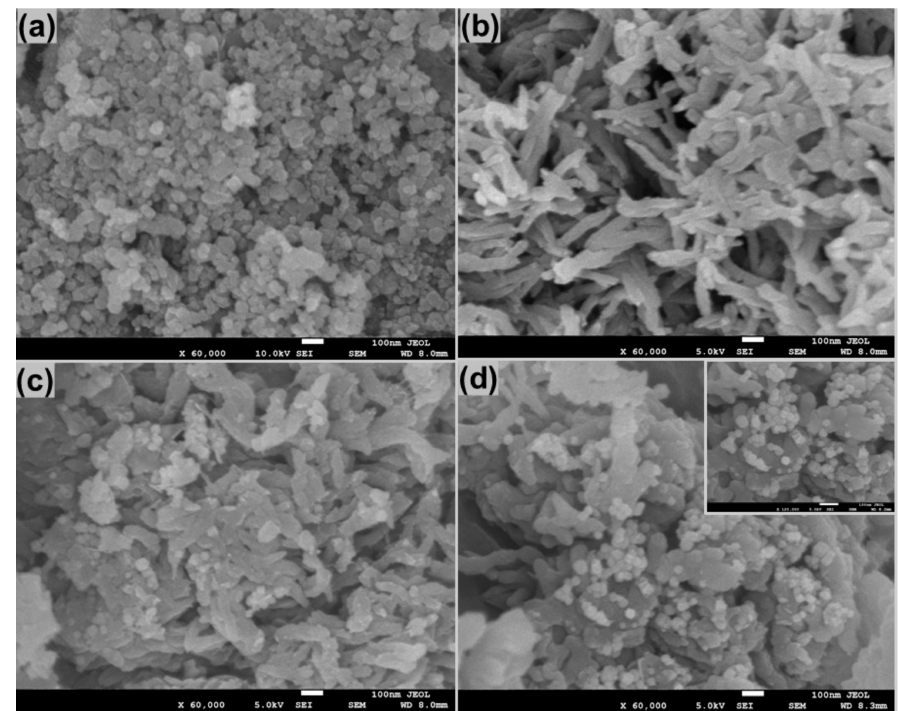
Figure 2. FESEM images of ( a ) cobalt oxide (Co 3 O 4 ) nanoparticles (NPs), ( b ) polyaniline (PANI), ( c ), Co 3 O 4 @PANI binary nanocomposite ( d ), silver (Ag) / Co 3 O 4 @PANI ternary nanocomposite and inset of Figure 1d showing Co 3 O 4 and Ag NPs decorated on PANI